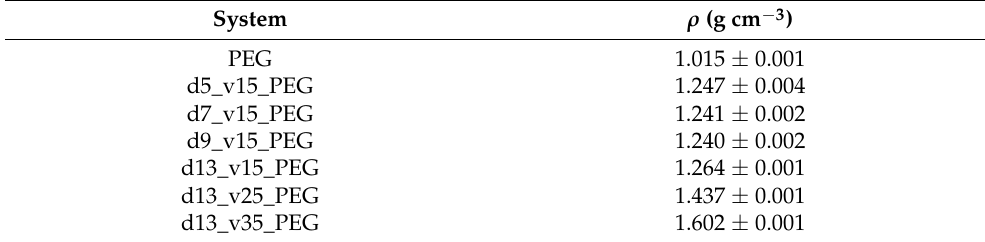
Table 2. Density of all PEG-silica systems studied in the present work ( T = 413 K and p = 1 atm).